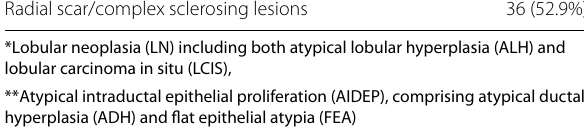
Table 2 Detailed lesion histopathological diagnoses Histopathological type